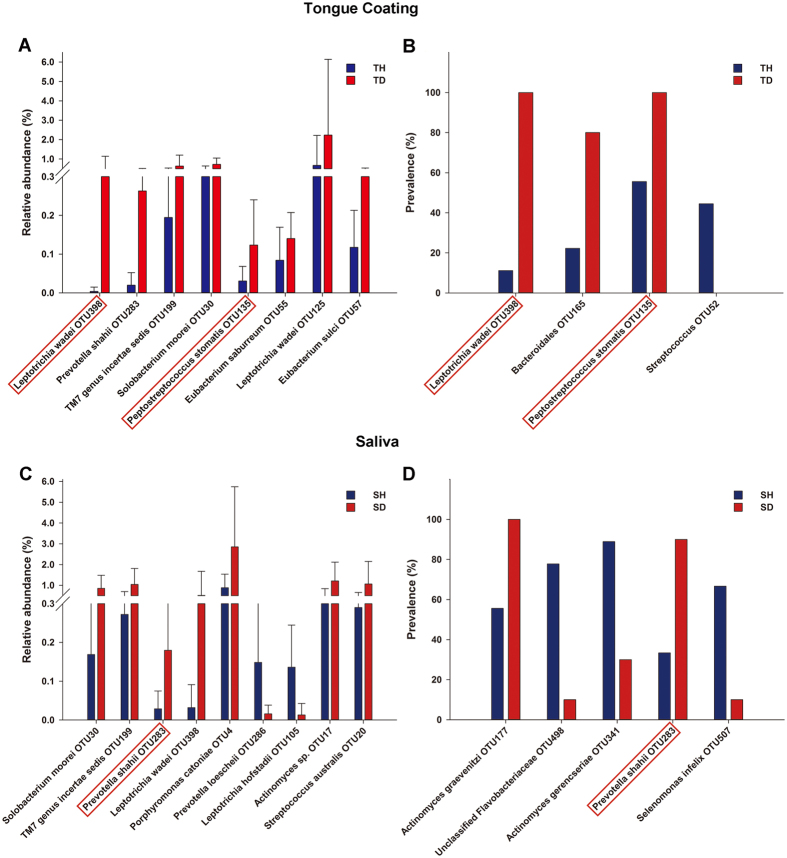
OTUs with different relative abundances and prevalences between the healthy and halitosis samples.(A) The graph depicts OTUs with different relative abundances and is based on Wilcoxon signed-rank test results from comparisons between healthy (TH) and halitosis tongue coating samples (TD). The bars represent the mean relative abundance (±SD). (B) OTUs with different prevalences were calculated based on Fisher’s exact test. Similar comparisons between the healthy (SH) and halitosis saliva samples (SD) are shown in (C) and (D). The OTUs framed by red boxes had different relative abundances and prevalences between the healthy and halitosis samples.